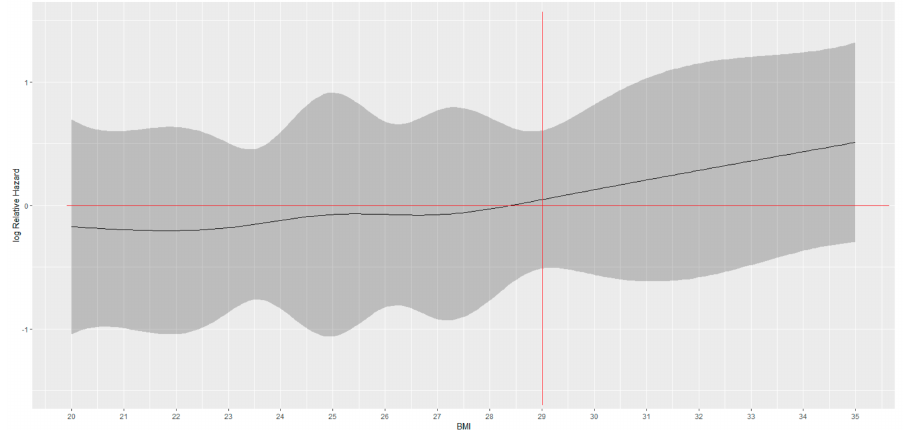
Figure 3. DFS hazard-ratio-smoothed curve for increasing values of BMI. Curve-fitting analysis showed that for BMI cut-off > 29 in AI-treated BC patients DFS was increasingly